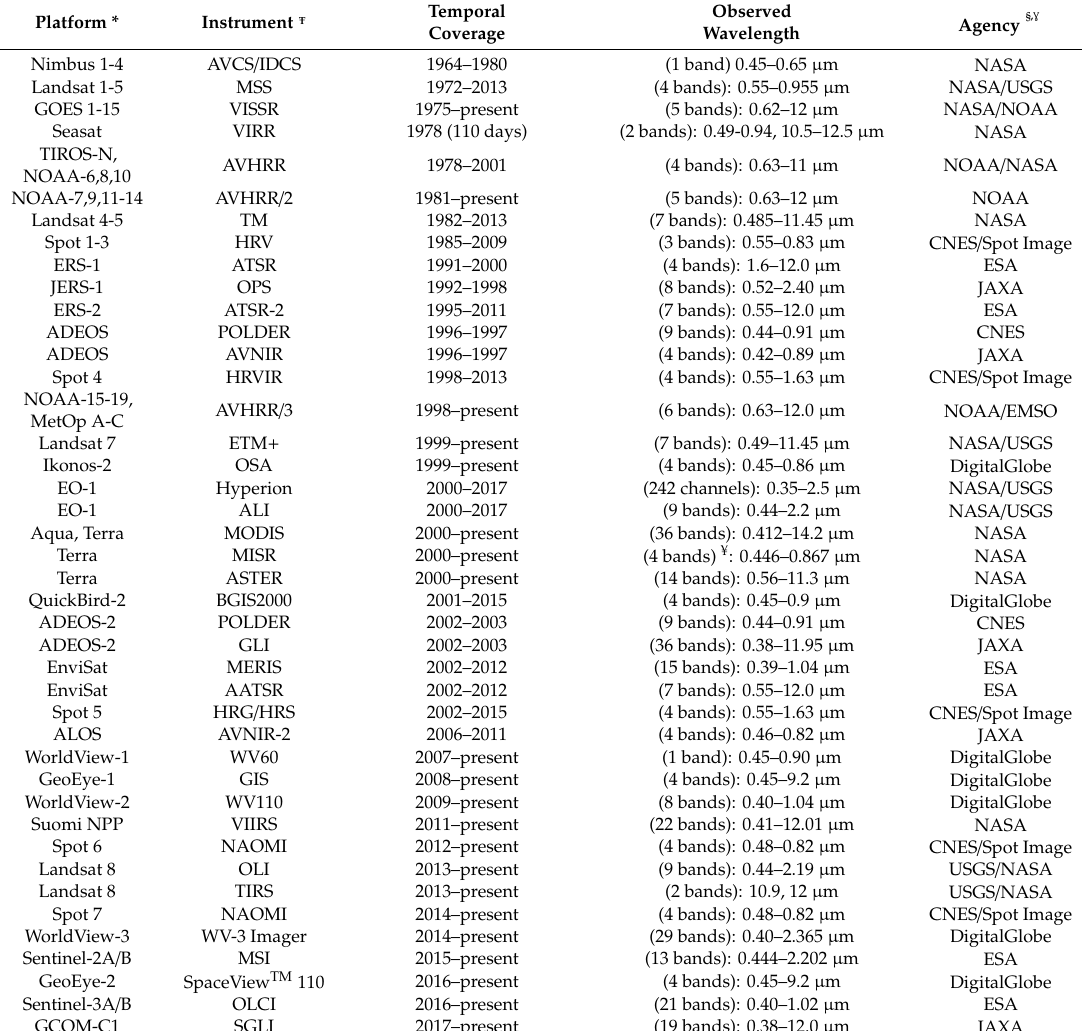
Table 2. Summary of optical and near-infrared remote sensing platforms, instruments, temporal coverage, observed wavelength, and managing agencies.